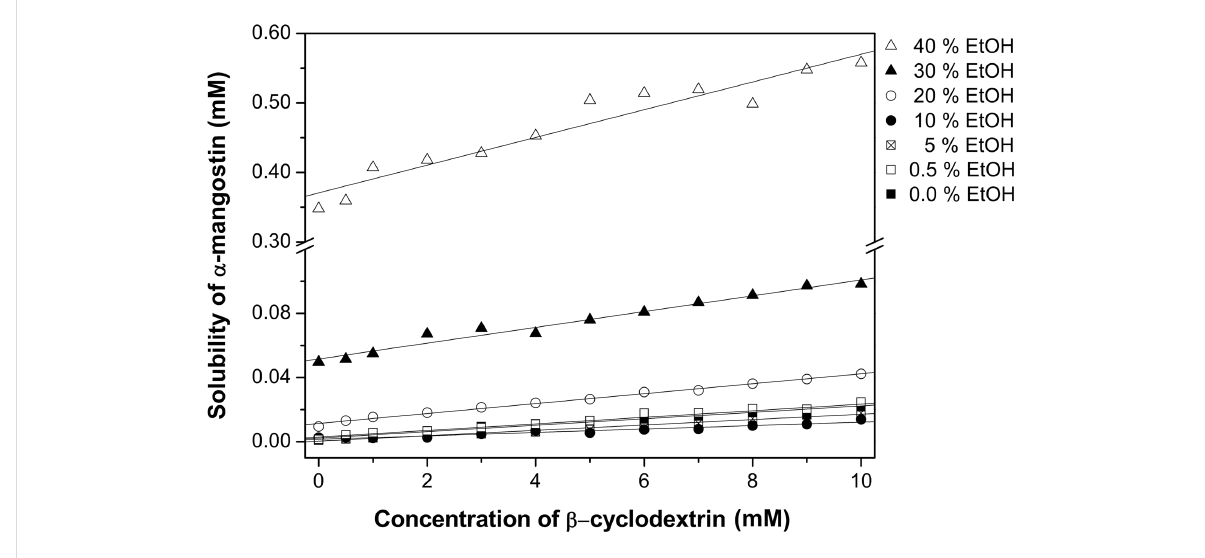
Figure 3: Solubility of α -mangostin as a function of β -CD for different ethanol concentrations.